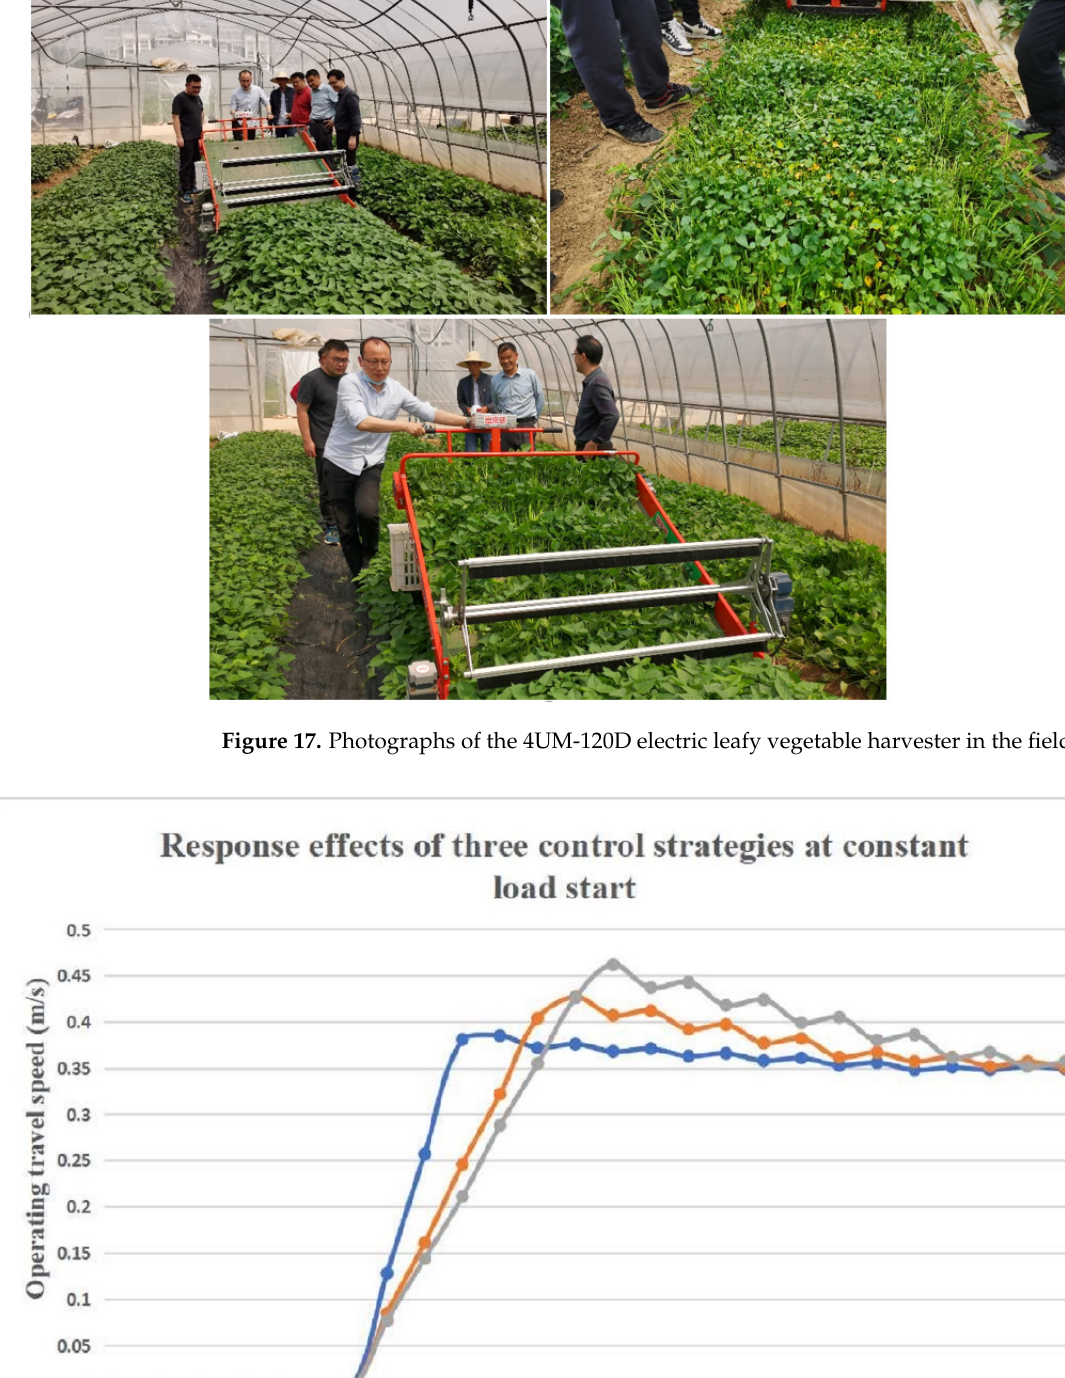
Figure 19. Response effects of three control strategies when the leafy vegetable collection baskets were full and unloaded under smooth operation of the harvester. As can be seen in Figure 18, at a constant load start of the harvester, the overshoot was 32% for the PID control algorithm-based walking drive system of the electric leafy vegetable harvester, 22% for the adaptive fuzzy PID control algorithm-based walking drive system, and 10% for the sliding mode control algorithm-based walking drive sys- tem. The time when the harvester’s travel speed first entered the ±2% range of 0.35 m/s and was not exceeded was taken as the adjustment time. Therefore, the adjustment time